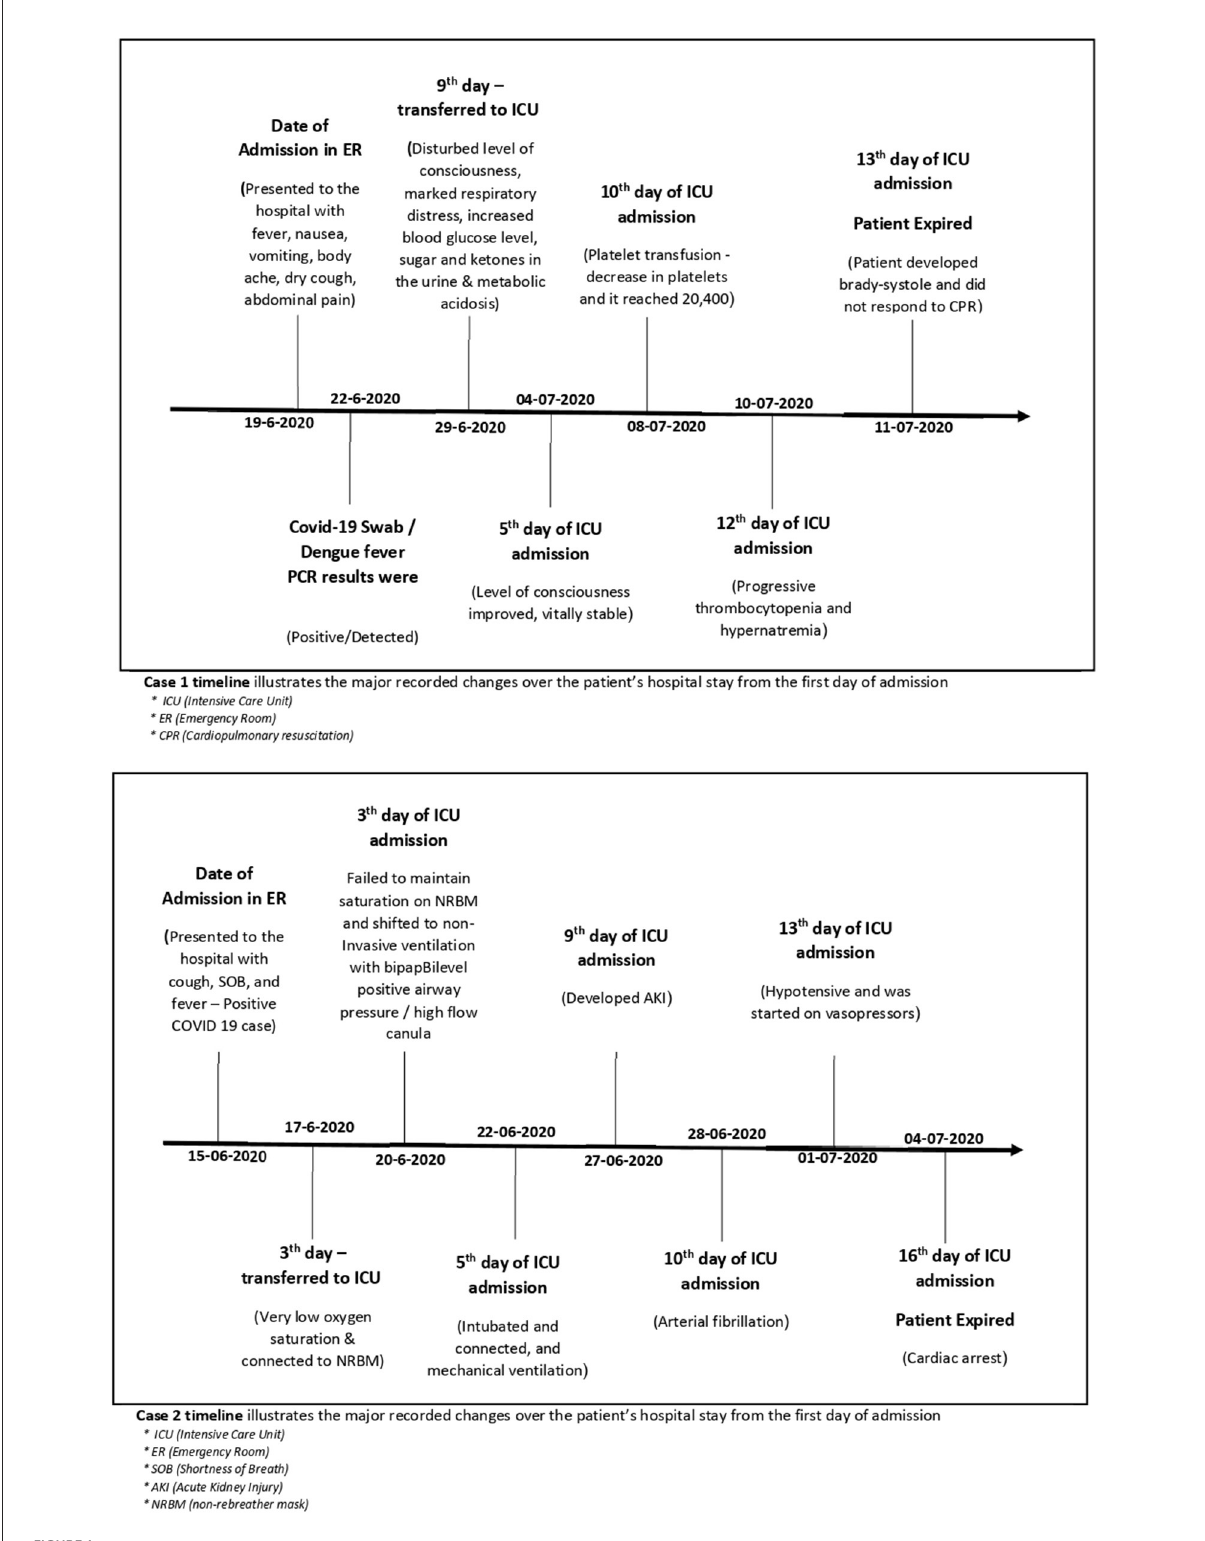
FIGURE1 Summary of timeline and activities of both